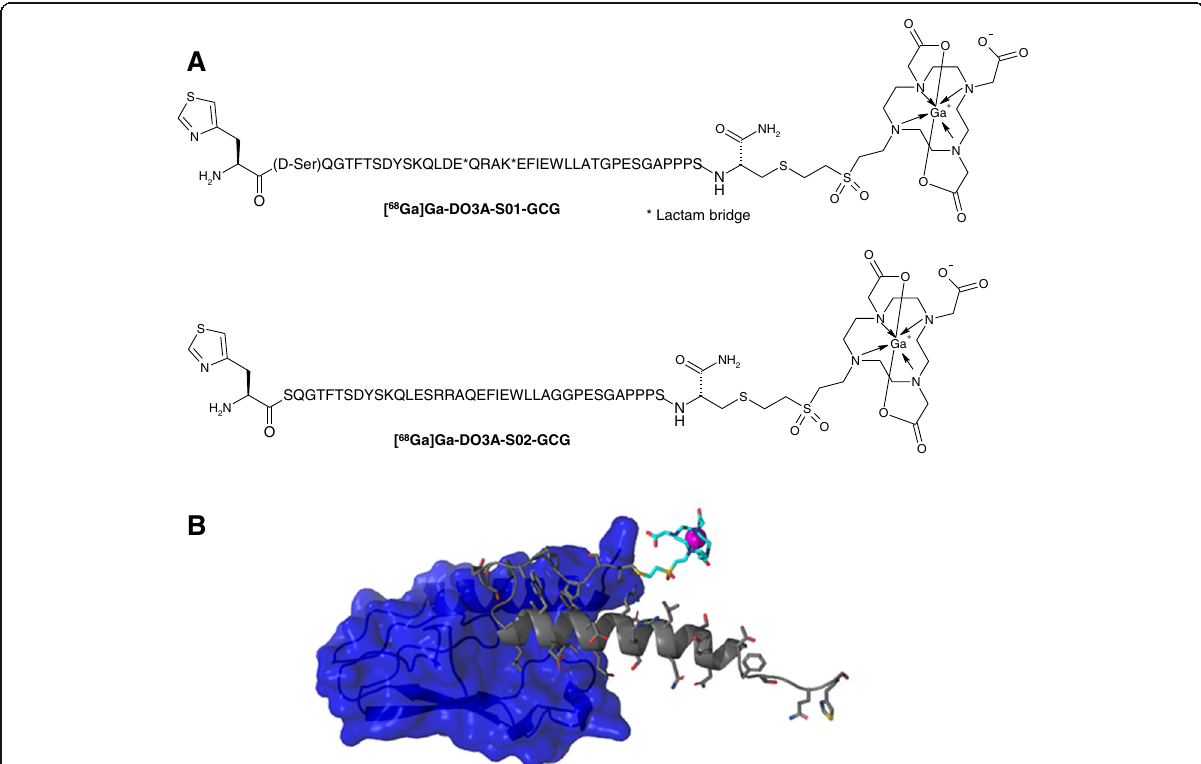
Fig. 1 Chemical formulae of [ 68 Ga]Ga-DO3A-S01-GCG and [ 68 Ga]Ga-DO3A-S02-GCG depicting the overall construct similarity with difference in the peptide sequence ( a ). Three-dimensional representation of predicted interaction between [ 68 Ga]Ga-DO3A-S02-GCG (gray peptide, cyan chelator, purple Ga(III), and blue GCGR) ( b )